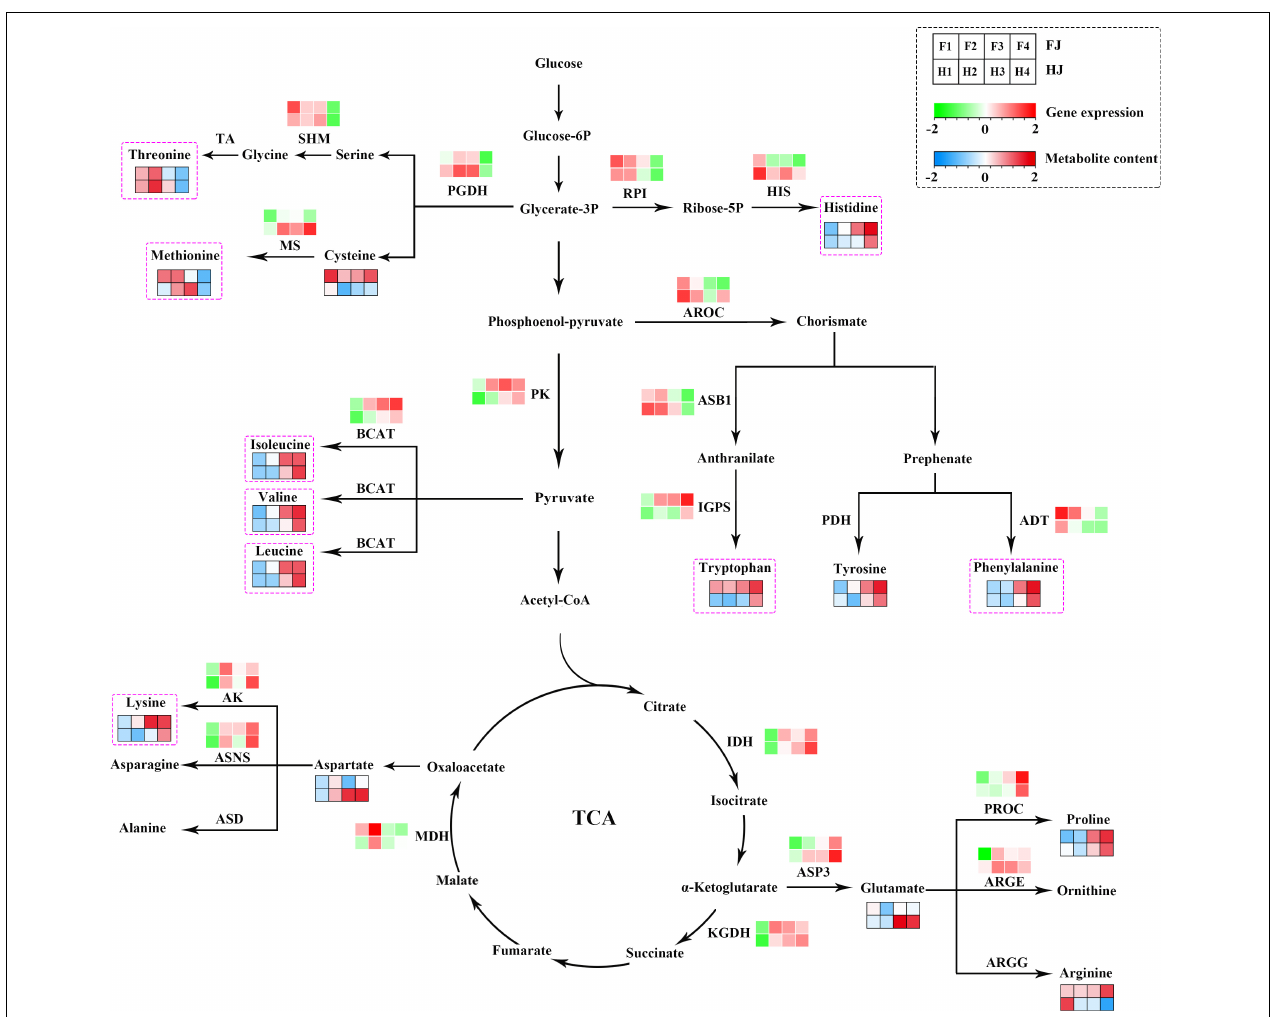
FIGURE 6 | Amino acid biosynthesis pathway in Zanthoxylum bungeanum leaves. The green and red rectangles represent the heatmaps of gene expression; the blue and red rectangles represent the heatmaps of metabolite abundance. Pink dotted box marks the nine essential amino acids for human body. IDH, isocitrate dehydrogenase; PGDH, D-3-phosphoglycerate dehydrogenase; PROC, pyrroline-5-carboxylate reductase; MS, 5-methyltetrahydropteroyltriglutamate –homocysteine methyltransferase; SHM, serine hydroxymethyltransferase; BCAT, branched-chain-amino-acid aminotransferase; PK, pyruvate kinase 1; AK, aspartokinase; ARGE, acetylornithine deacetylase; IGPS, indole-3-glycerol phosphate synthase; ASB1, anthranilate synthase beta subunit 1; HIS, imidazoleglycerol-phosphate dehydratase; AROC, chorismate synthase; RPI, ribose-5-phosphate isomerase; ASNS, asparagine synthetase; ADT, arogenate dehydratase/prephenate dehydratase 6; ASP3, aspartate aminotransferase 3; TA, threonine aldolase; PDH, prephenate dehydrogenase; ASD, aspartate 4-decarboxylase; ARGG, argininosuccinate